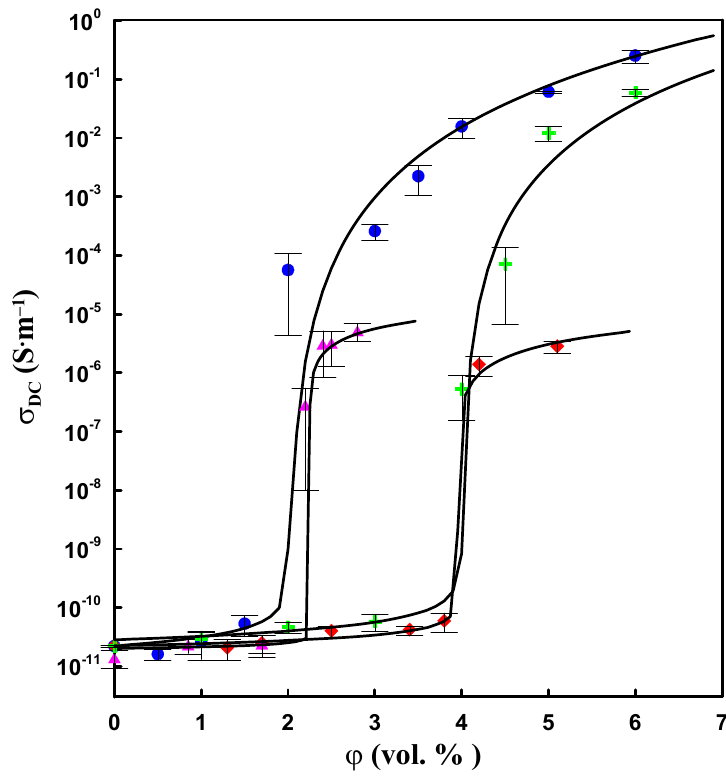
Figure 6. The dependence of DC electrical conductivity on CNT content is shown for CNT/silicone composite ( • mechanical mixing, + sonication) and CNT–DBSA/silicone composites ( ▲ mechanical mixing, ♦